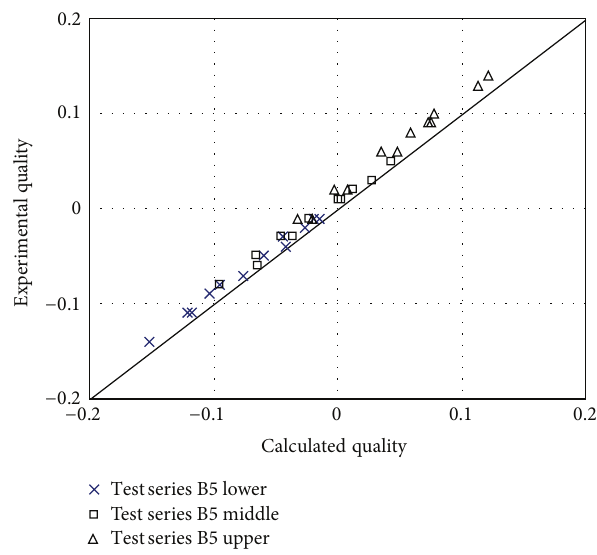
Figure 15: Deviation of measured void fraction from recalculated void fraction.